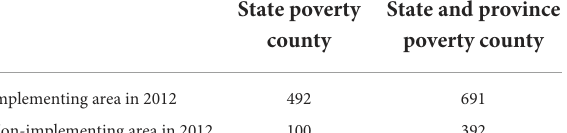
TABLE 1 Implementation of nutrition improvement programs within poor